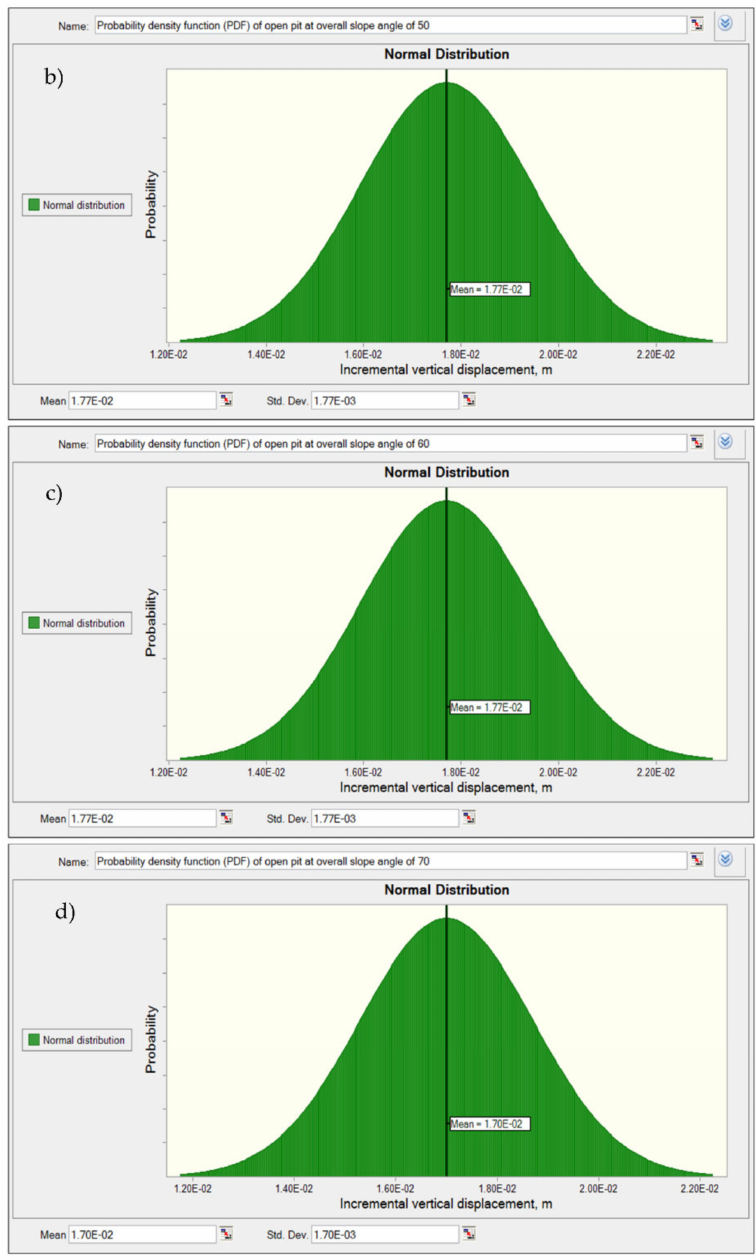
Figure 10. Probability density function (PDF) of incremental vertical displacement at different overall slope angles: ( a ) P f at overall slope angle of 40 ◦ , ( b ) P f at overall slope angle of 50 ◦ , ( c ) P f at overall slope angle of 60 ◦ and ( d ) P f at overall slope angle of 70 ◦